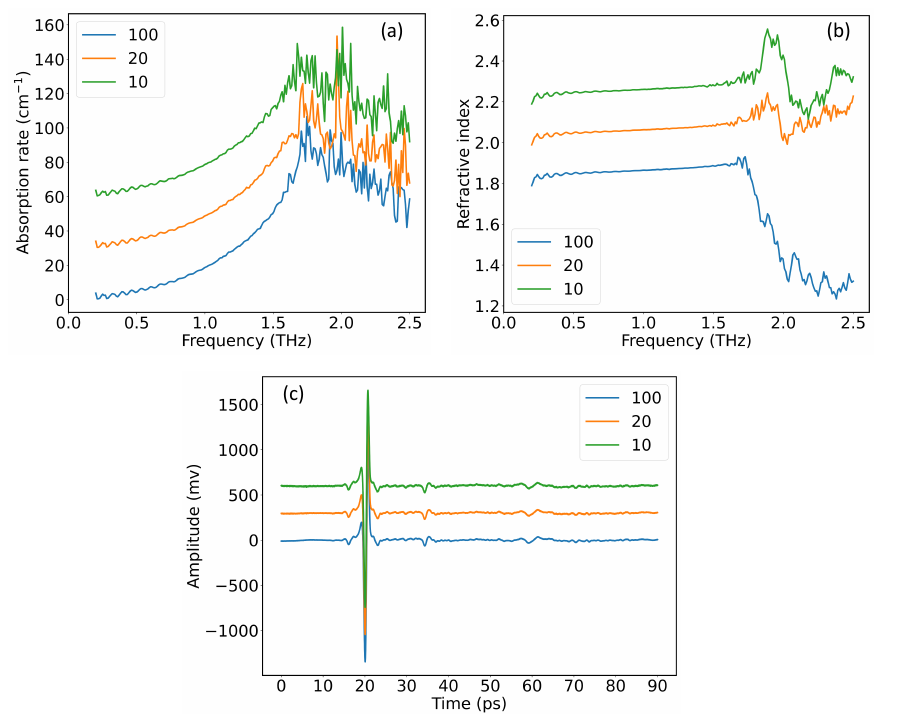
Figure 7. ( a ) Absorption rate, ( b ) refractive index, and ( c ) time-domain spectrum of D-Serine in training dataset (100) and testing datasets (20 and 10). Offset on the y -axis was used for